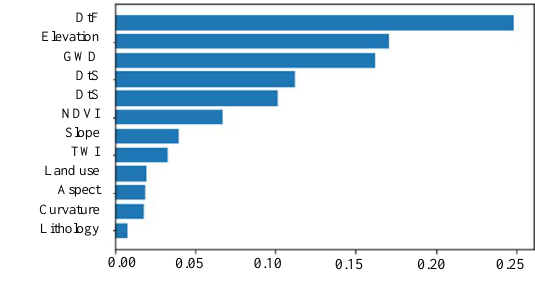
Figure 4. RF Feature importance based on MDI.